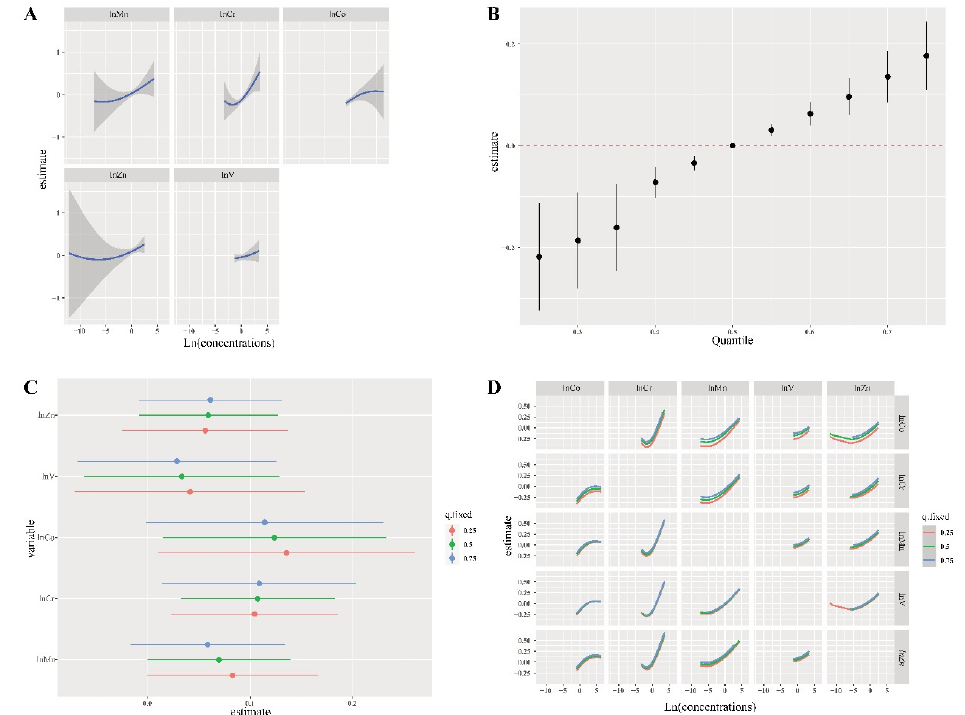
Figure 3. Joint effect of the five metals on male hyperuricemia risk using BKMR. Adjusted variables are the same as those listed for the single-metal model. ( A ) Single-metal exposure–response functions and 95% confidence intervals (shaded areas) for each metal with the other four metals holding at the median. ( B ) Overall effect of the mixture estimates and 95% confidence intervals. ( C ) Single-metal association (estimate and 95% confidence intervals). This plot compares hyperuricemia risk when a single metal is at the 75th vs. 25th percentile, when all the other exposures are fixed at either the 25th, 50th, or 75th percentiles. ( D ) Bivariate exposure response for each of the metals presented on the right longitudinal axis when other metals are presented on the upper coordinate axis holding at different quantiles (25th, 50th, and 75th), and all other metals are held at median